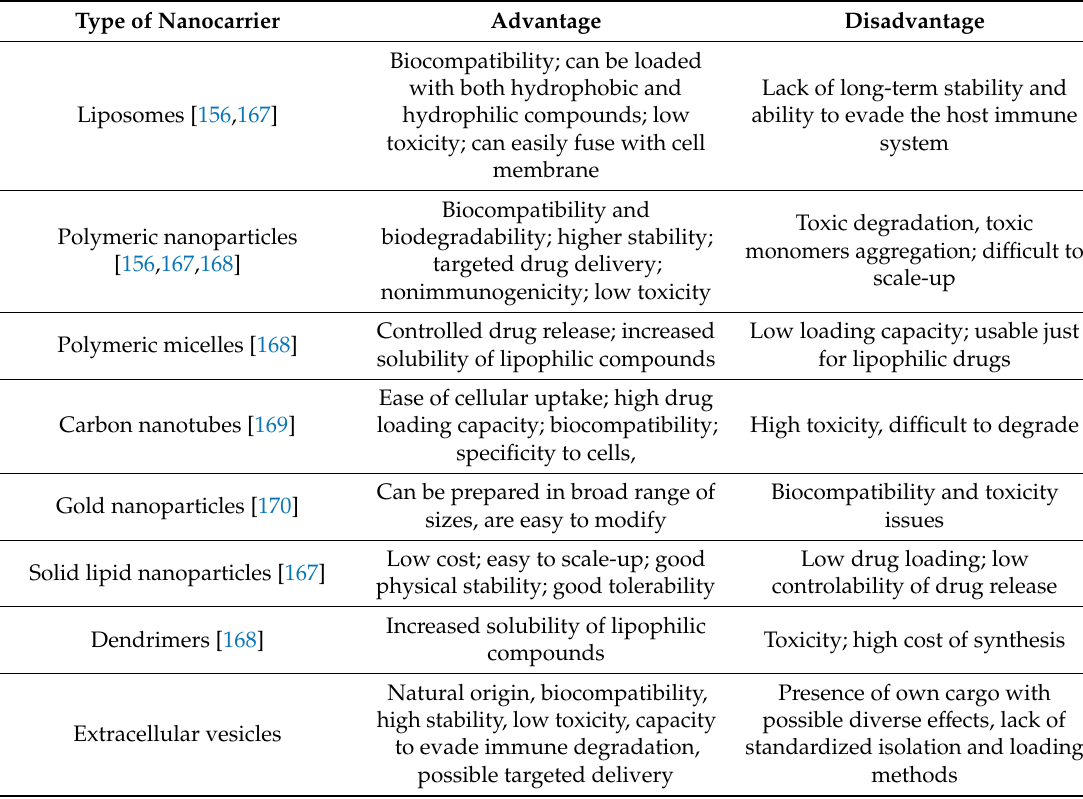
Table 1. Examples of nanocarriers with their advantages and